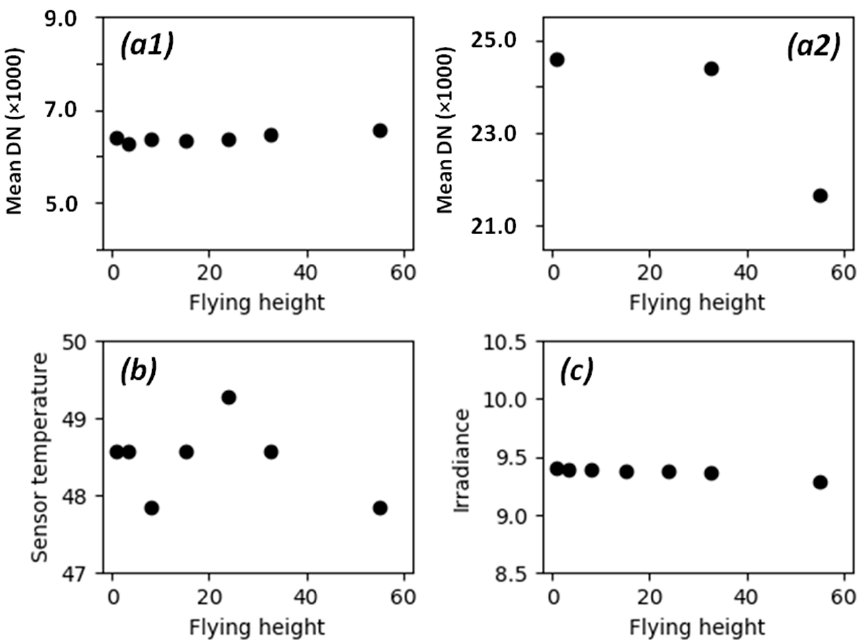
Figure 13. Mean pixel values for the green band over the 5% ( a1 ) and the 20% ( a2 ) reflectance calibration panels during the flight on 20 May 2019. The low number of observations for the 20% panel was due to saturation in some images. Images were captured while descending over the panels with stable camera temperature ( b ) and irradiance ( c ).